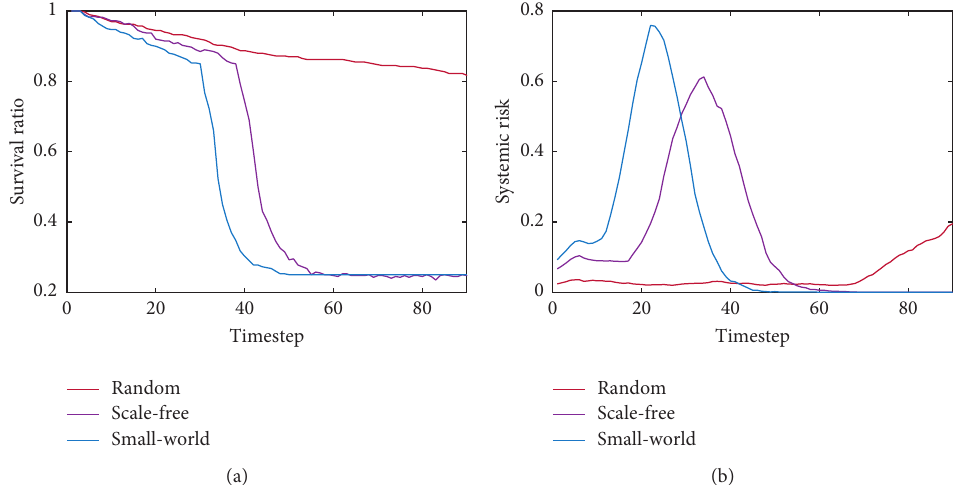
Figure 3: (a) Changes in the survival ratio of diverse interbank networks. (b) Dynamic changes in systemic risk of diverse interbank